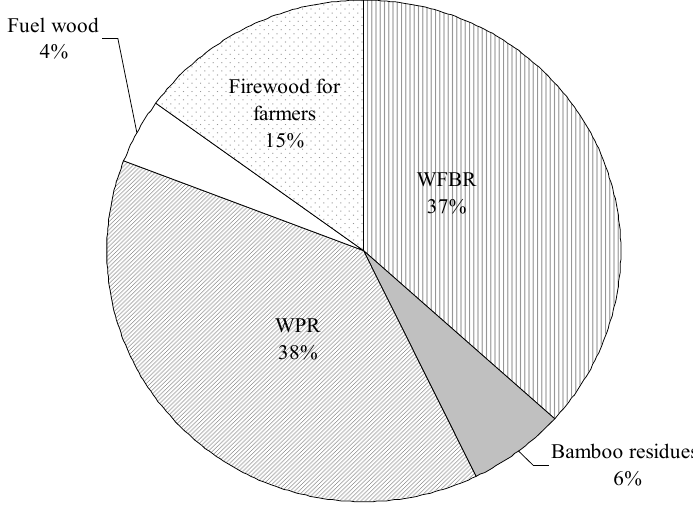
Figure 2. Composition of Chinese forestry biomass energy resources in